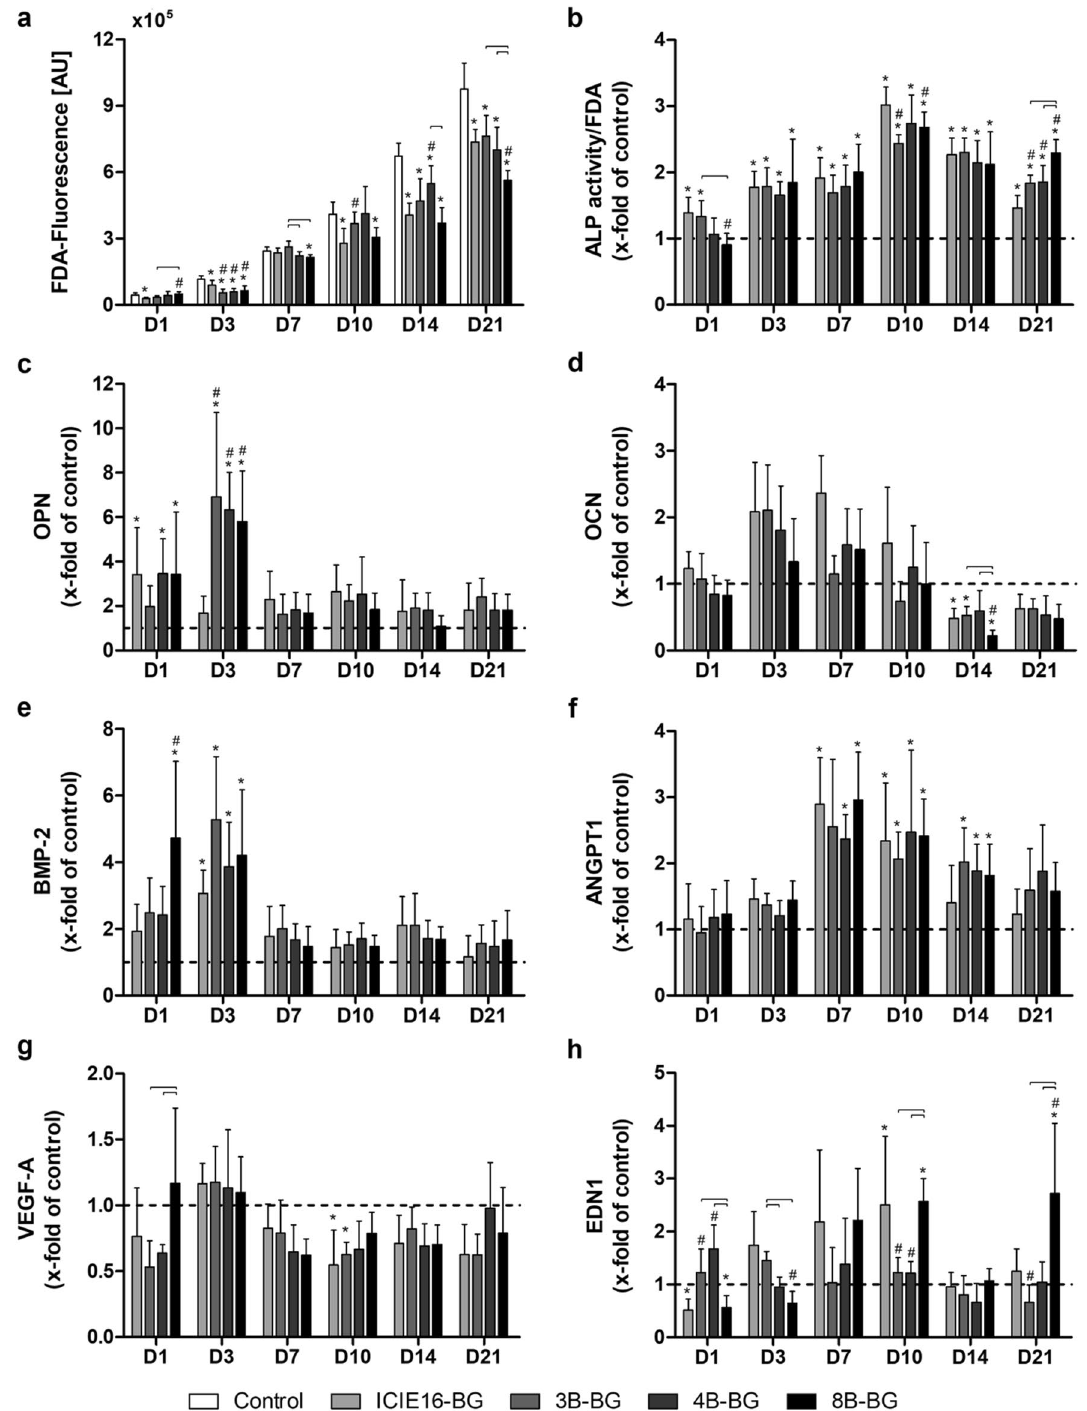
Figure 3. Viability of BMSCs ( a ), ALP activity of BMSCs (normalized to FDA) ( b ), expression of osteogenic marker genes, namely OPN ( c ), OCN ( d ) and BMP-2 ( e ) and expression of angiogenic marker genes, namely ANGPT1 ( f ), VEGF-A ( g ) and EDN1 ( h ). Except for viability measurements ( a ), values are normalized to the control group indicated by the dashed line ( b–h ). [*] marks significant differences compared to the control group, [#] marks significant differences compared to ICIE16-BG. Significant differences between the B-doped BGs are highlighted with